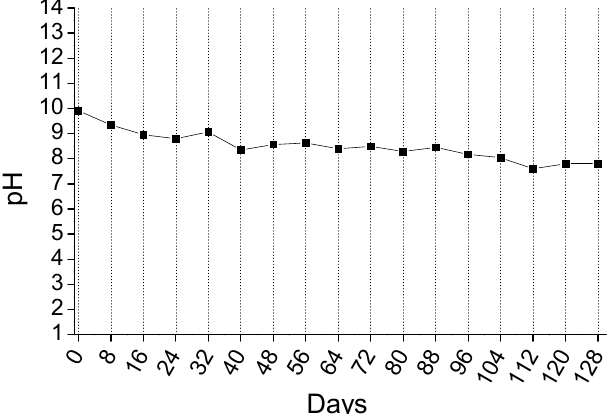
Figure 7. The evolution of surface pH values of coated concrete specimens, during the application of the long-term duration acid spraying test.